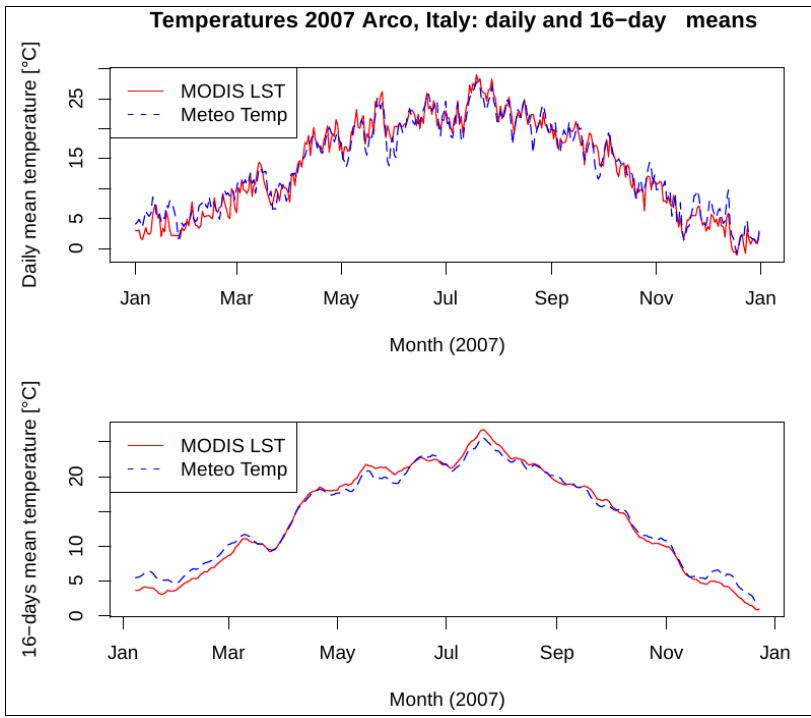
Figure 6. Comparison of daily mean temperature and 16-day aggregated mean temperatures in Arco, Italy: time series of the meteorological station (blue dashed) versus MODIS LST values (red) as extracted from 1,460 reconstructed Aqua/Terra scenes at the pixel position of the Arco station in Trentino (10.887125E,